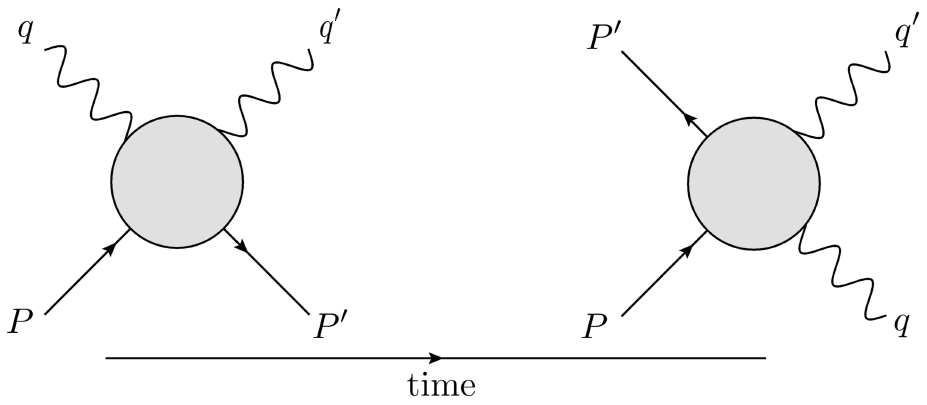
Figure 5 . Crossing symmetry shown in terms of Feynman diagrams. The two processes are related to the same set of Feynman diagrams by simply exchanging the initial and final particles. The right plot corresponds to the t -channel process of the left